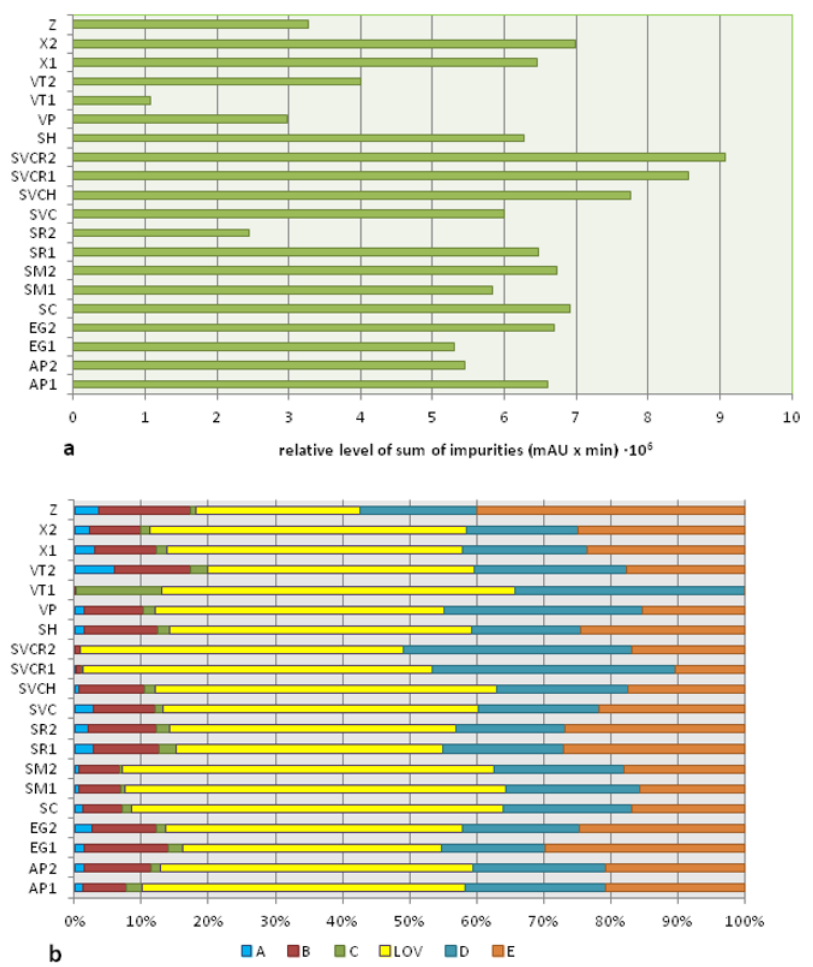
Figure 2. The relative level of summarised impurities (a) and cumulative percentage of six impurities (b) obtained from chromatograms for 20 studied commercial simvastatin